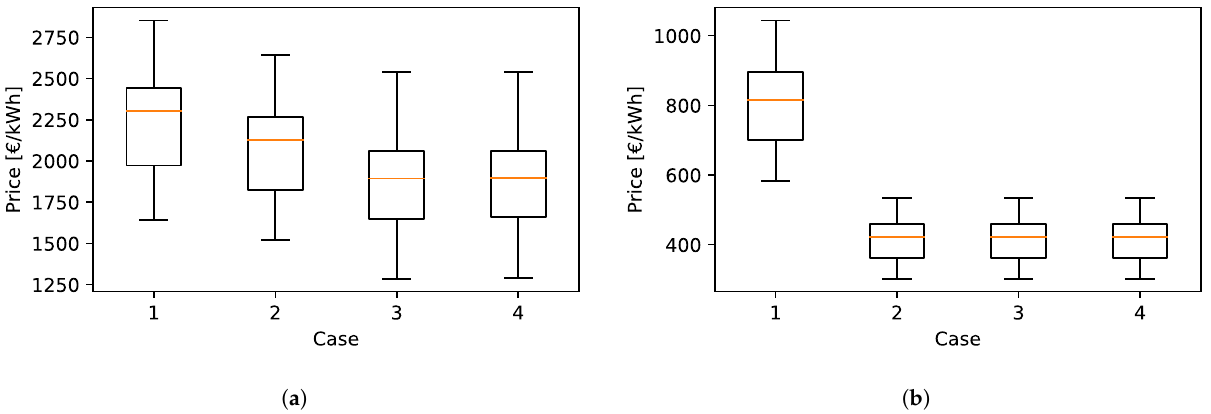
Figure 10. Cases price variation for residential and commercial users, considering all the scenarios. ( a ) Residential. ( b ) Commercial